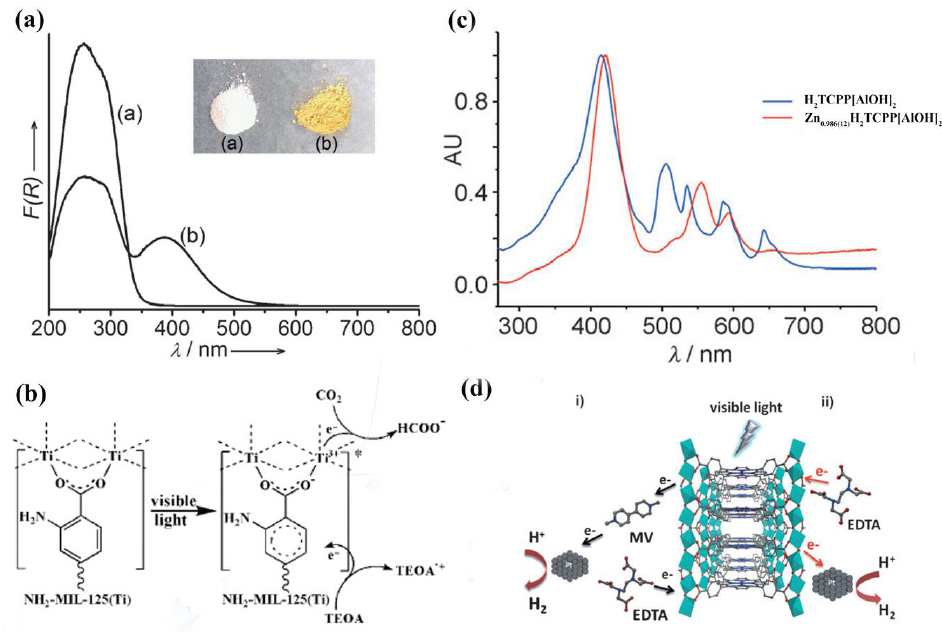
Figure 1. ( a ) UV/Vis spectra of (a) MIL-125(Ti) and (b) NH2-MIL-125(Ti). The inset shows the samples. ( b ) Proposed mechanism for the photocatalytic CO 2 reduction over NH2-MIL-125(Ti) under